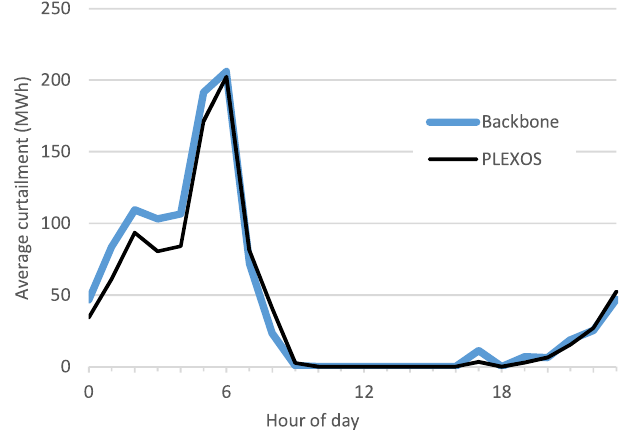
Figure 11. Average curtailment of wind power and solar photovoltaic (PV) as a function of time of